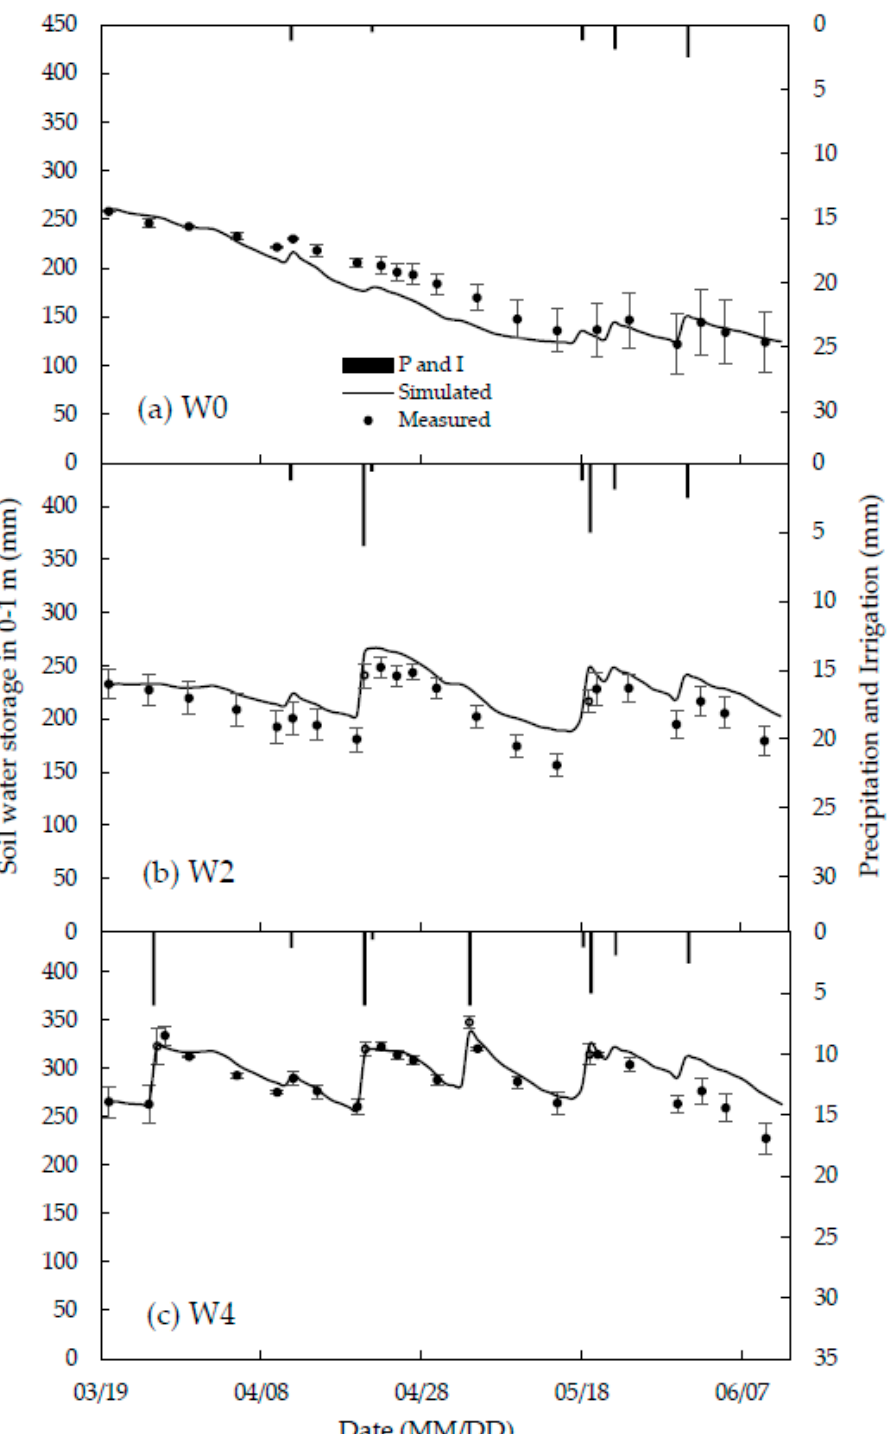
Figure 7. Comparison between simulated and measured soil water storage in 0–1 m soil layer in calibration treatments. The error bars are the standard deviation of field measurements in the two or four medium fertilization plots, as shown in Figure 6 (e.g., the error bars in W0 is calculated from W0FM-1 and W0FM-2; W2 from W2-1FM-1, W2-1FM-2, W2-2FM-1, and W2-2FM-2). The P and I represent precipitation and irrigation.